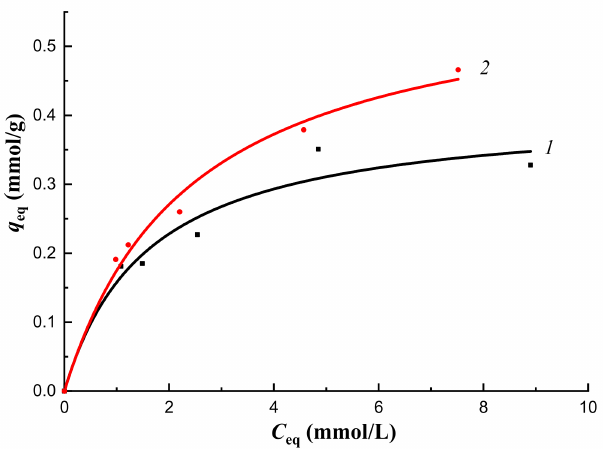
Figure 14. The equilibrium sorption of total cholesterol in vitro from blood plasma by sorbents CP-1 ( 1 ) and MIP-1-6 ( 2